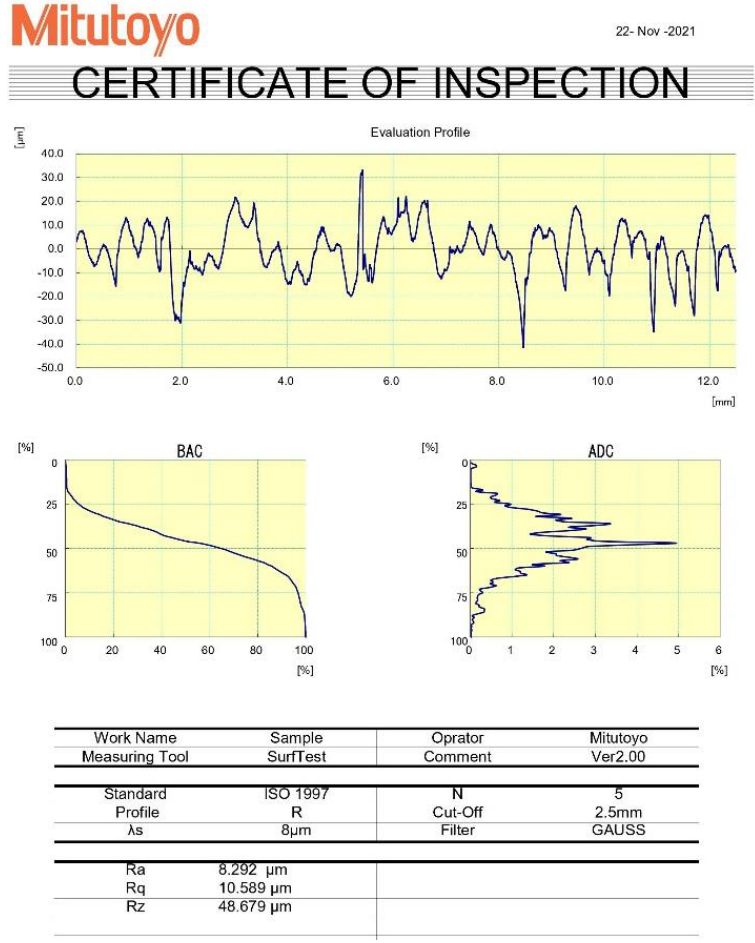
Figure 4. Surface roughness report generated by SURFTEST SJ-210 for run 12.